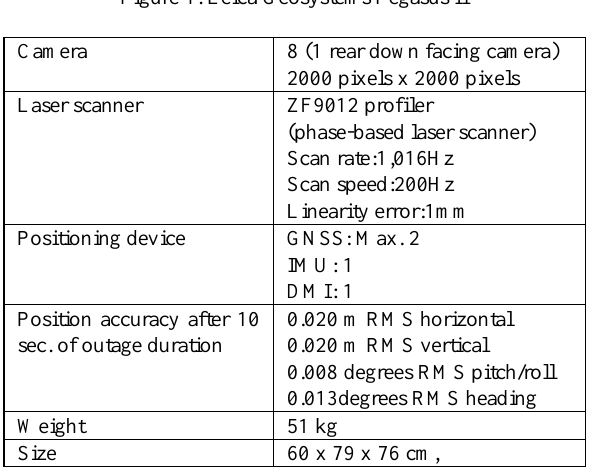
Table 1. Specifications of Leica Geosystems Pegasus II